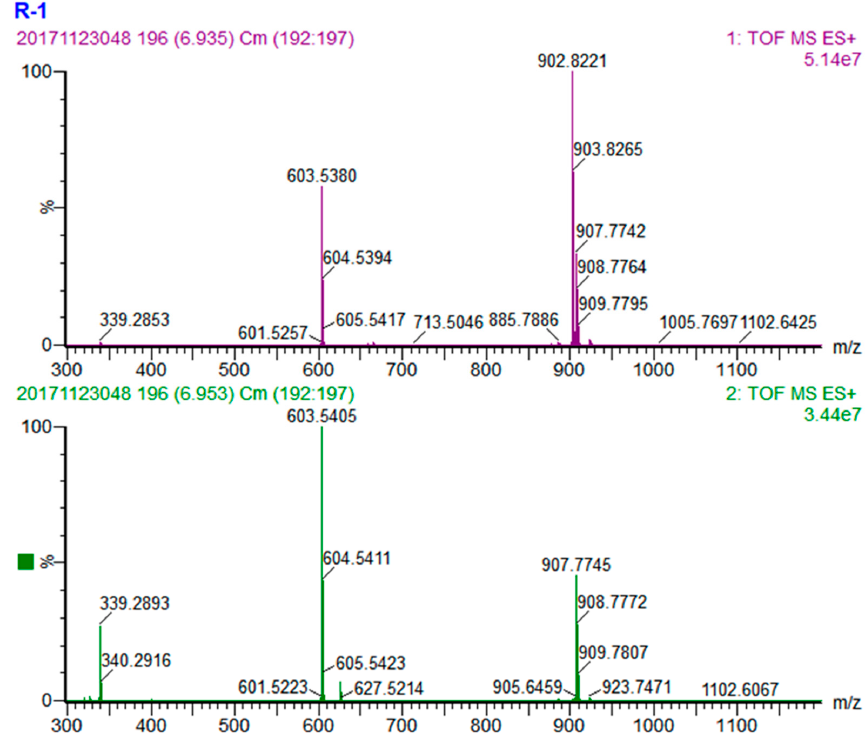
Figure 2. MS spectra of OOO. ( Upper ) MS1 spectrum and ( lower ) MS2 spectrum. The peak at the retention time 6.58 min is an example for identifying TAG with two different fatty acids. The quasi-molecular ion of this TAG is [M + NH 4 ] + at m/z 900.8047 (Figure 3), the molecular formula was calculated as C 57 H 102 O 6 from the MS1 information. The MS fragment from MS2 showed two major fragment ion peaks [M-RCOO + H] + at m/z 601.5235 and 603.5349, which correspond to diacyl fragments LO + and OO + from the TAG by eliminating an oleic acid (with the m/z 299.2816) and a linoleic acid (with the m/z 297.2698), respectively. Due to that the relative natural abundances of LO + and OO + are 100% and 43% (Figure 3), and the well accepted knowledge that fatty acid on sn-2 position might have higher bond energy and is harder to be eliminated [29], this TAG is tentatively identified as LOO.